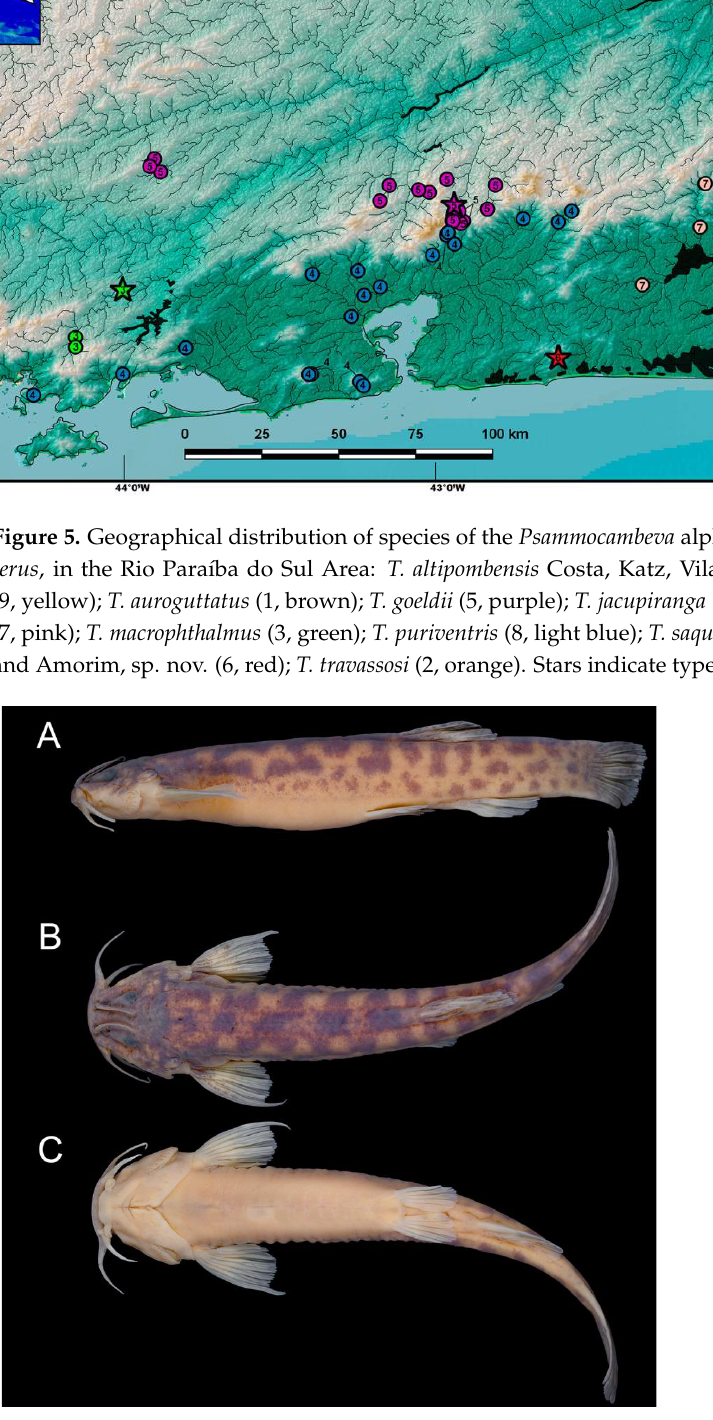
Figure 6. Trichomycterus auroguttatus , UFRJ 11675, topotype, 59.2 mm SL: ( A ) lateral, ( B ) dorsal, and ( C ) ventral views.